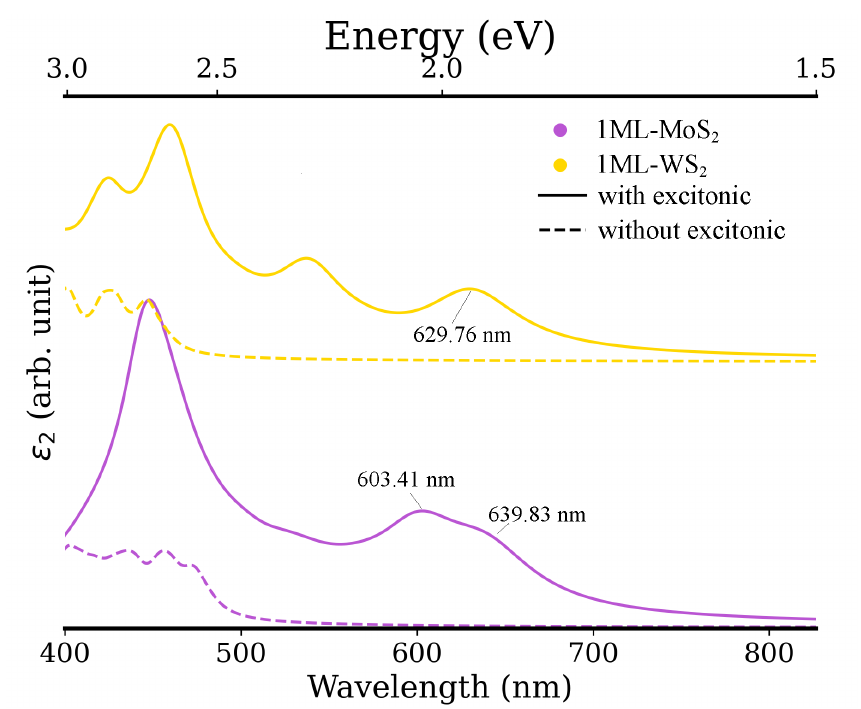
Figure 5. Imaginary part of dielectric function ( ε 2 ) as calculated for MoS 2 (purple) and WS 2 (yellow) monolayers by means of GLLBSC E XC .